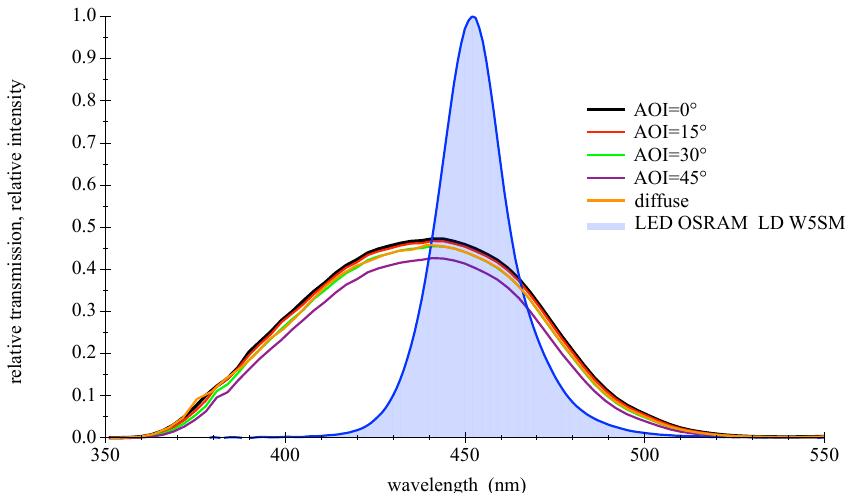
Figure 9. Measured spectral transmission curves for a colored glass bandpass filter Hoya B440 with a directed light source at different AOIs and with a diffuse light source. The measured relative intensity distribution of a deep blue LED OSRAM LD W5SM is also given as filled curve to illustrate the overlap. For further information, please refer to the appendix in Appendix